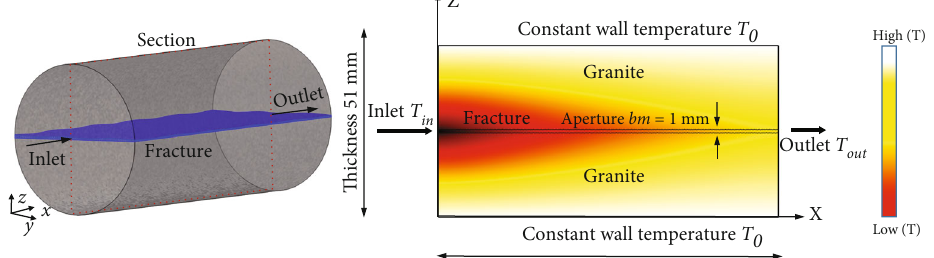
Figure 1: Numerical models of single rock fractures.